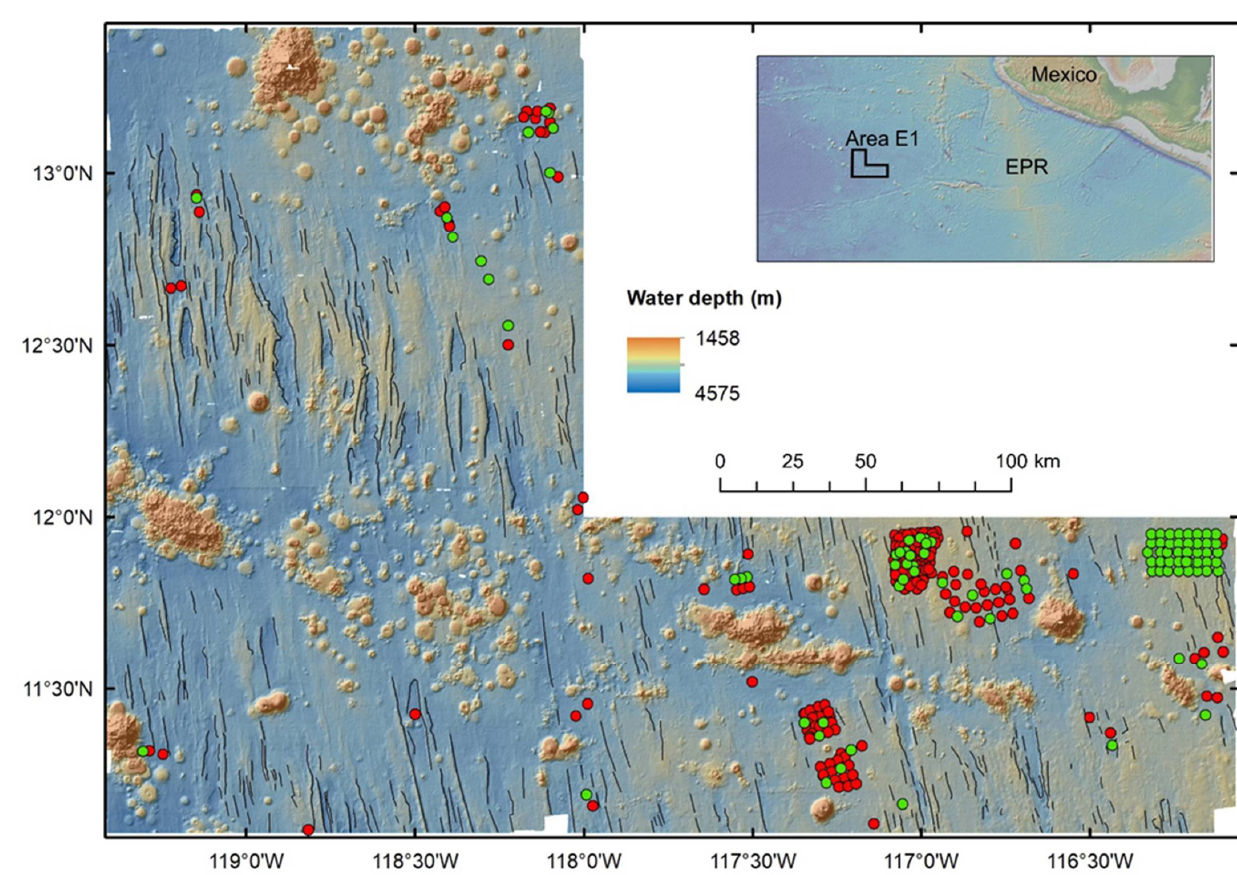
Figure 2. Distribution of training (red; N = 188 box corer sites) and validation (green; N = 91 box corer sites) data used to develop and validate the artificial neural network model in Area E1. As training and validation data, the Mn nodule abundance (wet weight in kg/m 2 ) from box core sites was used. The small map indicates the location of the working area in the NE Pacific. Thin black lines show faults identified from the bathymetric map and, in some cases, verified by seismic data